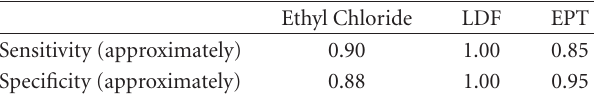
Table 2: Pulp test results from the Evans et al. [89] study. The disease prevalence in this study was